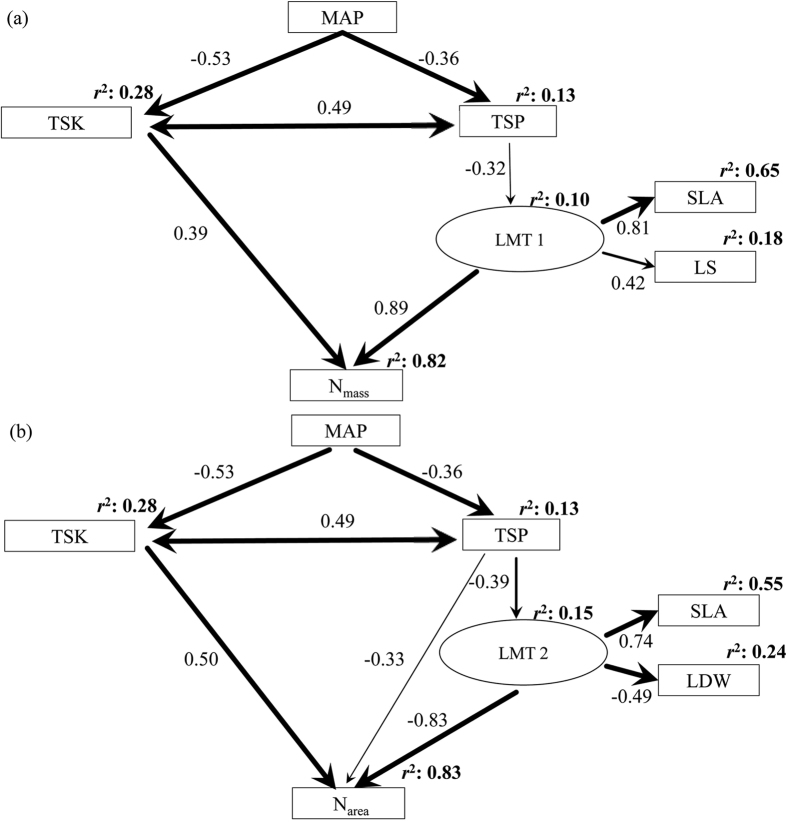
Results of the drivers for leaf nitrogen content.(a) Multiple drivers for leaf nitrogen concentration per mass (Nmass). (b) Multiple drivers for leaf nitrogen concentration per area (Narea). Single headed arrows indicate a hypothesized causal effect of one variable upon another. Double headed arrows indicate correlations. Insignificant (p > 0.05) paths were eliminated. Narrow arrows indicate p < 0.05; wider arrows indicate p < 0.01; and the widest arrows indicate p < 0.001. Signs on arrows indicate standardized regression weights or correlation indices. Signs at the top-right corner of each variable are the proportion of variance explained. LMT 1, leaf morphological traits incorporated from specific leaf area and leaf size; LMT 2, leaf morphological traits incorporated from specific leaf area and leaf dry weight; other abbreviations with units are explained in Table 1.